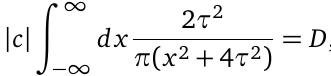
Figure 14: Non-equilibrium dynamics of the mutual information I intervals A and A after the quench from the BEC to the attractive Lieb-Liniger with γ = − 2. 1 2 I (continuous line) is plotted as function of the time after the quench. Results are for two A 1 : A 2 intervals of length (cid:96) = 10 at distance d = 10. The contributions of the different multiparticle bound states of different sizes n are also